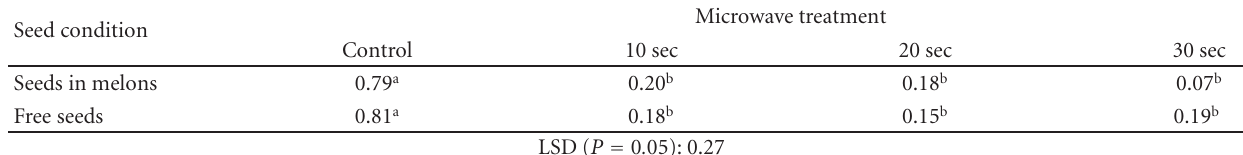
Table 2: Mean fraction of paddy melon seeds that survived microwave